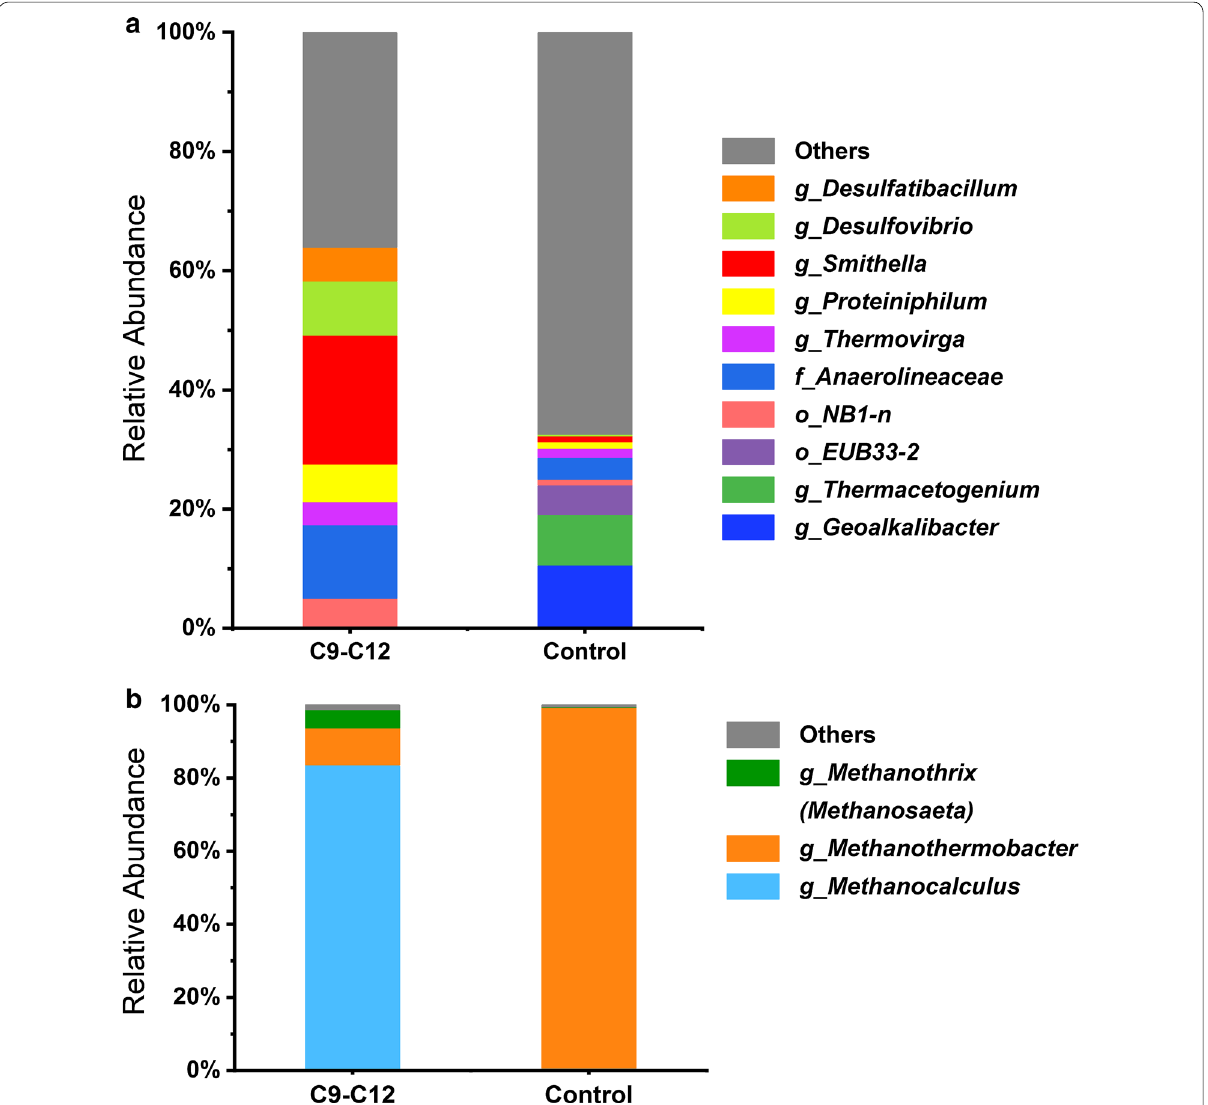
Fig. 3 Microbial community compositions in the alkane‑amended enrichment cultures and alkane‑free control cultures as determined by Illumina sequencing of 16S rRNA genes. a Bacterial population in both cultures. Sequences comprising more than 3% in at least one culture were shown. b Archaeal population in both cultures. Sequences comprising more than 1% in at least one culture were shown. The notations in the legend g, f, and o stand for the OTUs assigned to genus, family and order levels,